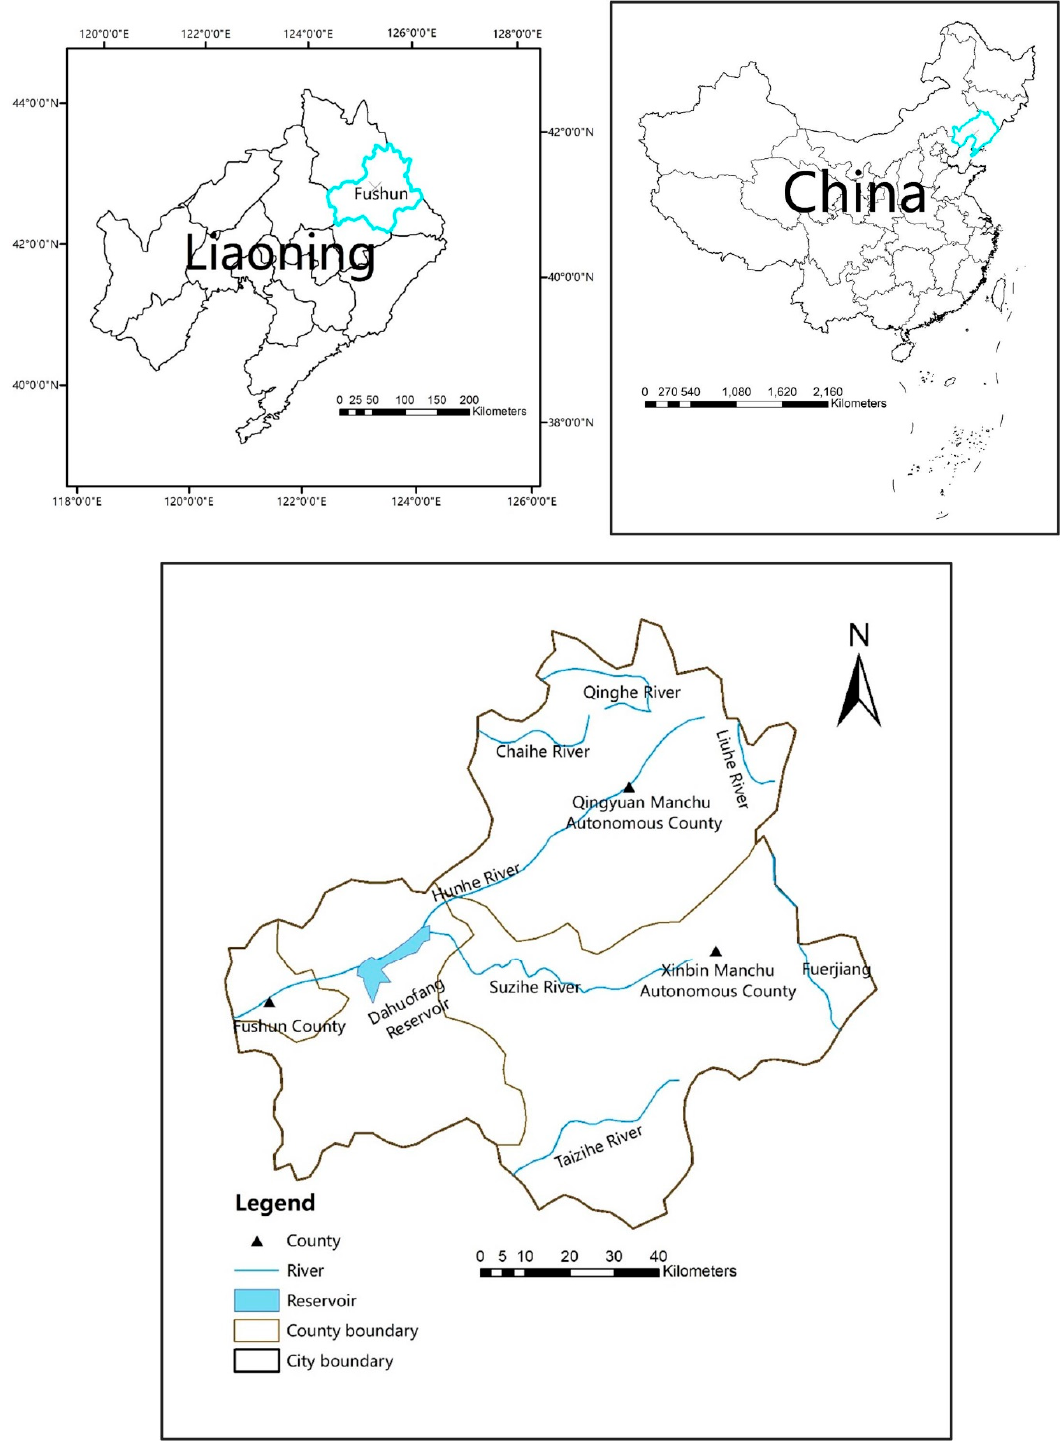
Figure 1. Location of the study area and distribution of major rivers in the area.